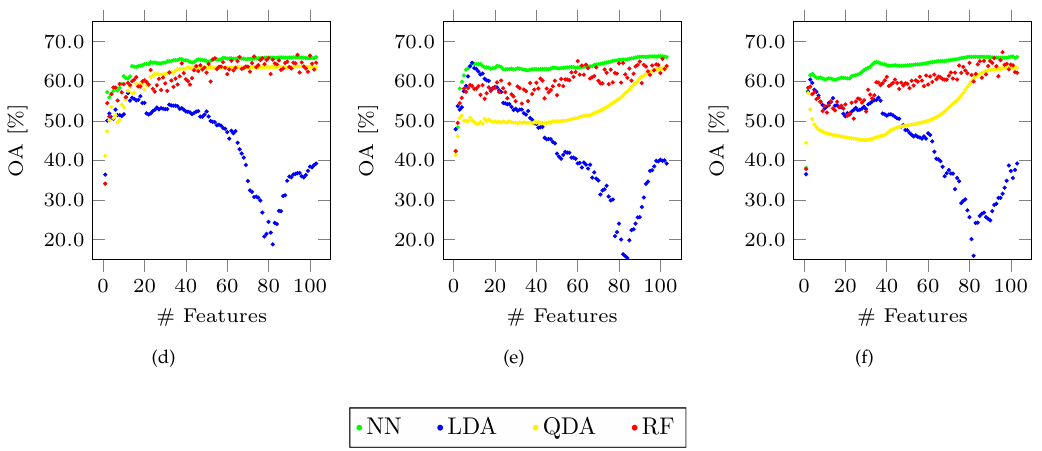
Figure 7. Classification results derived for the Pavia University dataset (9 classes) via sequential forward selection when using ( a ) the PCA; ( b ) the RF-MDPA; ( c ) the GRM; ( d ) the MUI; ( e ) the TUI and ( f ) the BOFR. Table 2. Classification results derived with the Random Forest (RF) classifier for the Pavia Centre dataset (9 classes).